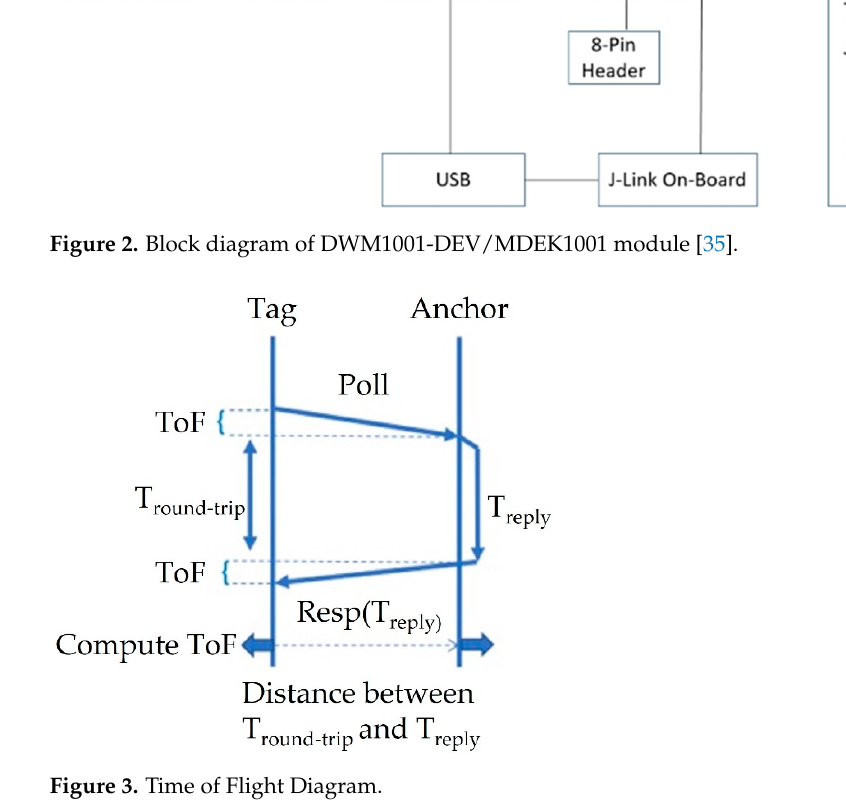
Figure 3. Time of Flight Diagram.